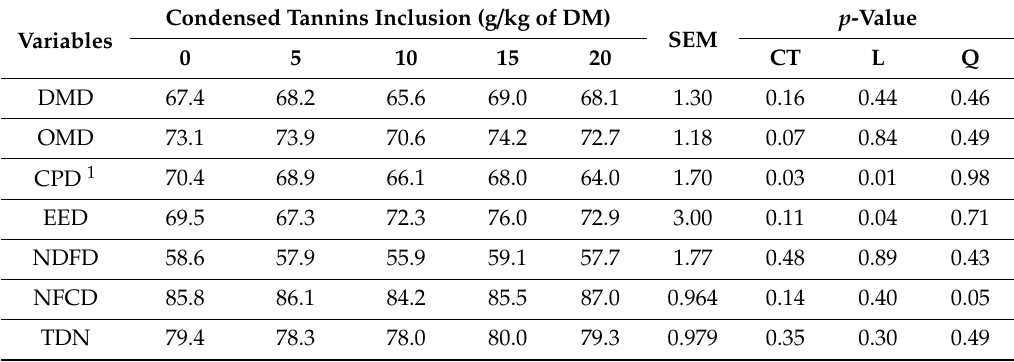
Table 4. Apparent digestibility of dry matter and nutrients (%) in steers receiving diets with increasing levels of condensed tannins extract from Acacia mearnsii